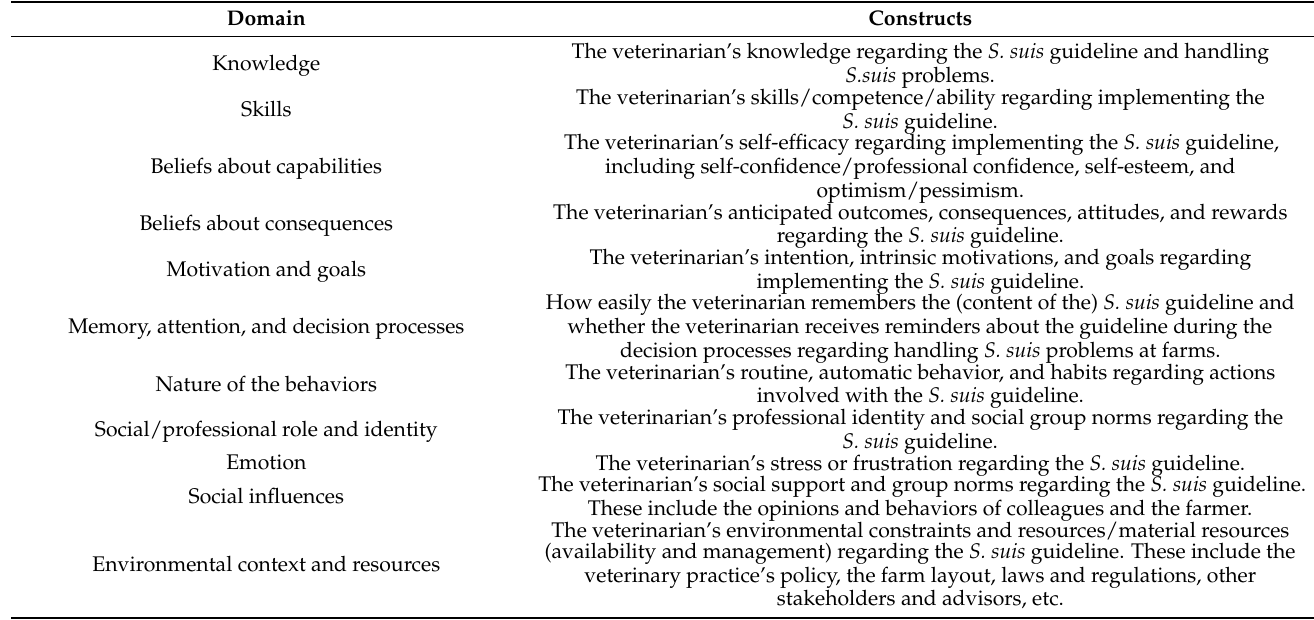
Table 3. Domains of the theoretical domains framework and what they construct in the study: “Why Veterinarians (Do Not) Adhere to the Clinical Practice Streptococcus suis in Weaned Pigs Guideline: A Qualitative